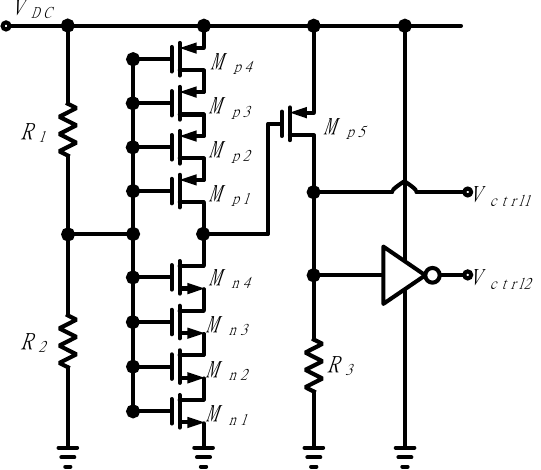
Figure 5. Control circuit for generating control voltages that switch adaptive operation.